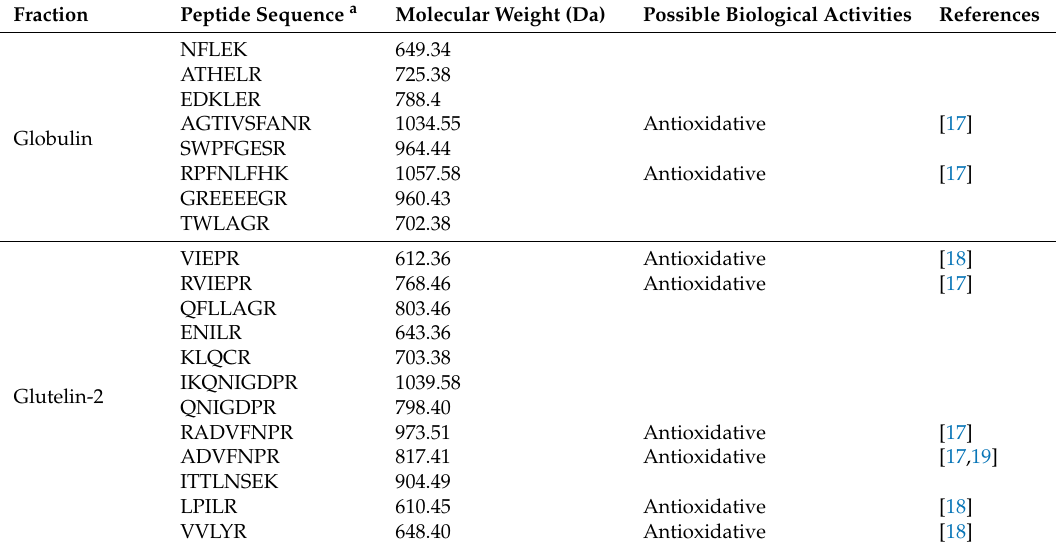
Table 3. Peptides from coconut cake protein fractions isolated and identified by LC-MS/MS and their potential biological activity.